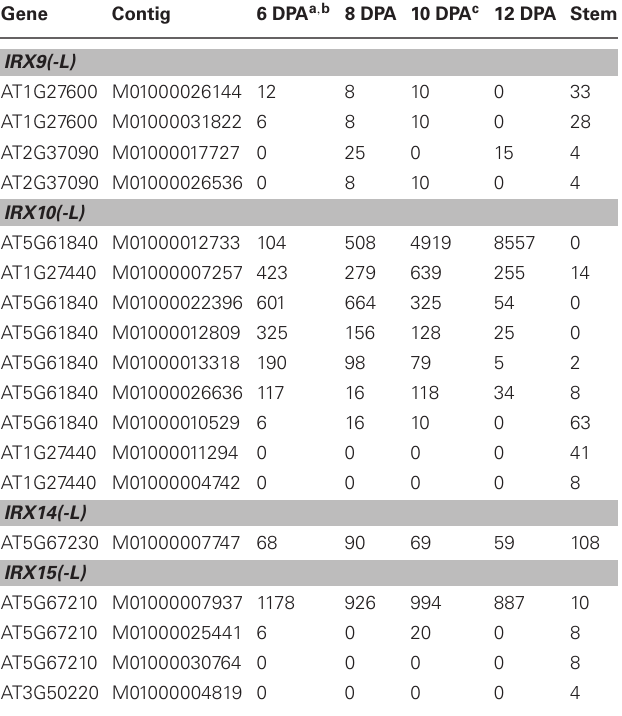
Table 2 | All transcripts from psyllium stem and mucilaginous layers encoding proteins homologous to Arabidopsis IRX9(-L), IRX10(-L), IRX14(-L), and IRX15(-L).